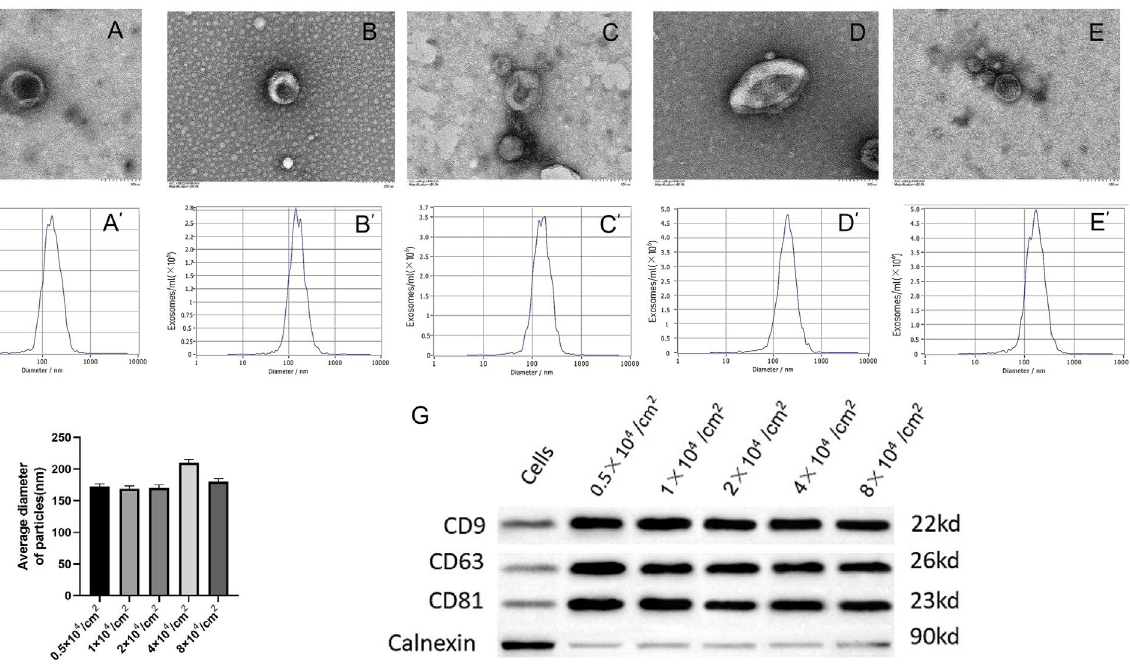
Densities on hBMSCs To study the effects of different hPDLSC exosomes derived from cultures with dif- ferent initial cell densities (0.5 × 10 4 , 1 × 10 4 , 2 × 10 4 , 4 × 10 4 , and 8 × 10 4 /cm 2 ) on bone